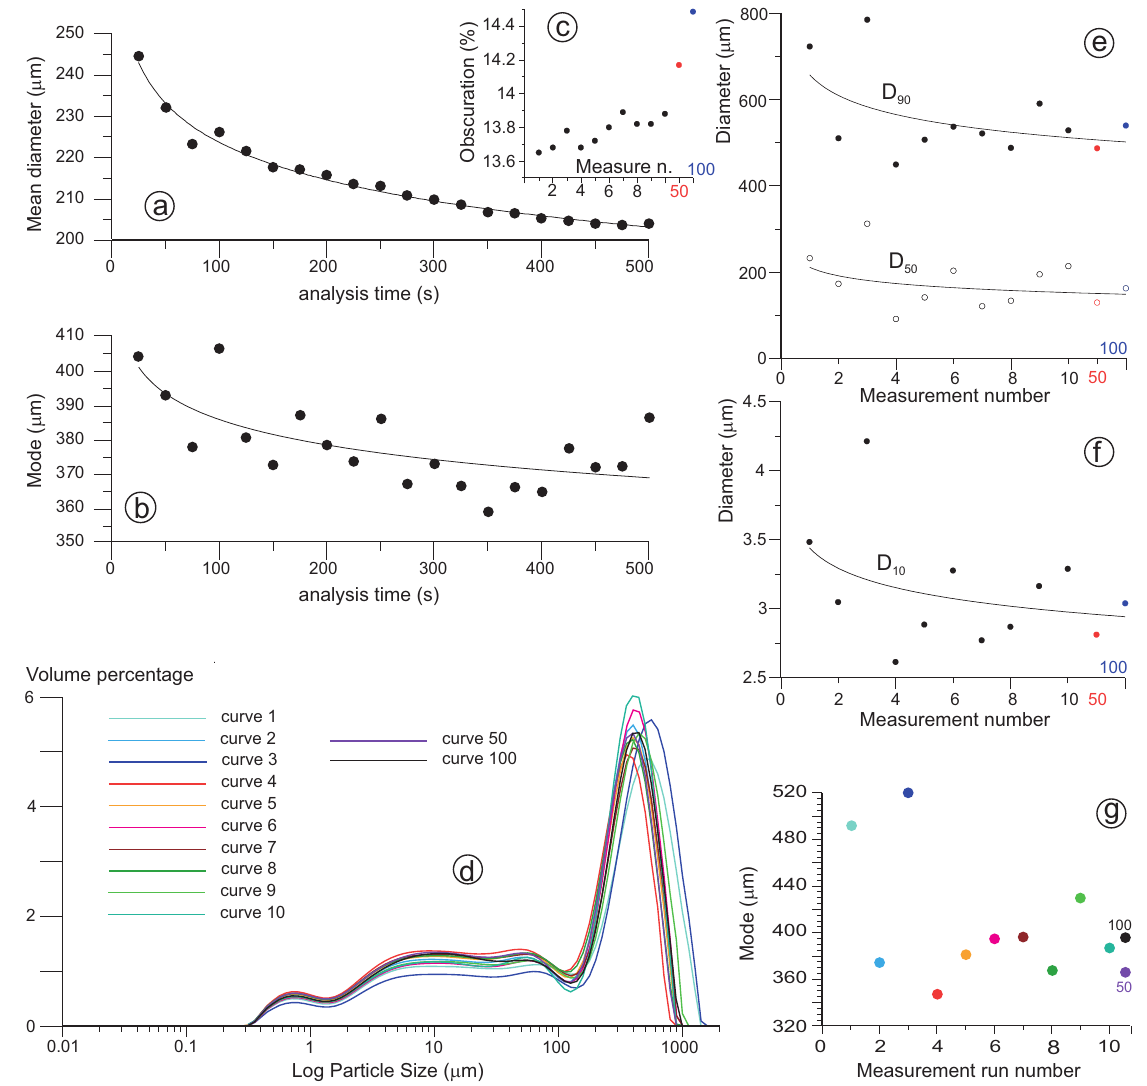
Fig. 14. Analysis of data from the test MP2000 5 on -sample aliquot CABRE3d (Fig. 9). (a) Mean diameter values averaged every five measurement runs. (b) Average modal values corresponding to data in (a). In both cases, the best fits indicate an exponential decay. (c) Laser obscuration values recorded during the first 10 runs (black dots), compared with the values after 50 (red dot) and 100 (blue dot) measurement runs. (d) Granulometric curves computed for the first 10 runs, compared with the ones from the 50th and 100th run. (e) Progression of D 50 and D 90 percentiles during the first 10 measurement runs. Data after 50 (red dot) and 100 (blue dot) runs are provided for comparison. (f) Progression of D 10 percentiles during the first 10 measurement runs. Data after 50 (red dot) and 100 (blue dot) runs are provided for comparison. (g) Progression of modal values during the first 10 measurement runs (colour code as in (d)). Data after 50 (grey dot) and 100 (black dot) runs are provided for